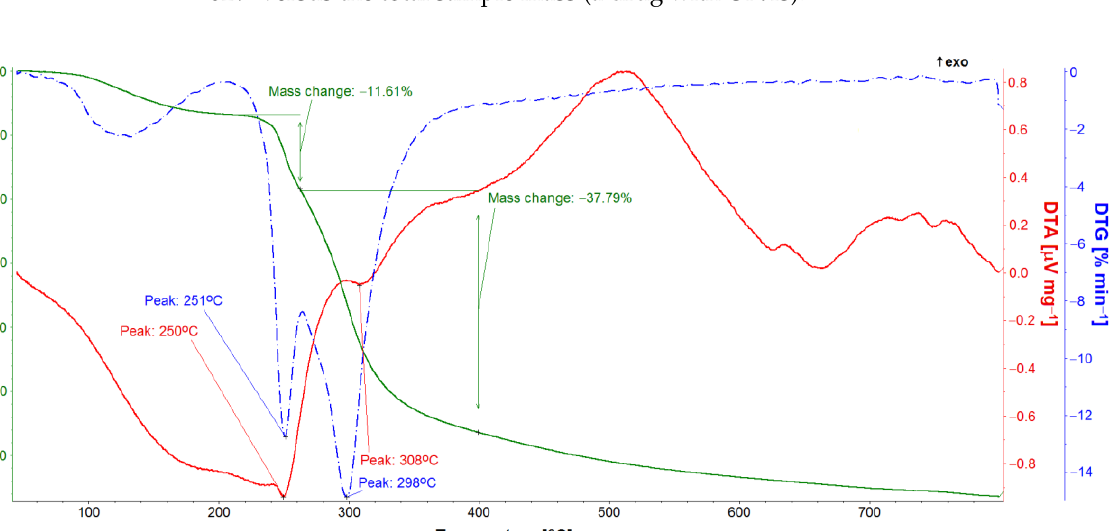
Figure 12. TG, DTA, and DTG curves and evolved gas analysis of gentamicin sulfate sample. Figure 13. TG, DTA, and DTG curves of gentamicin sulfate-loaded ONTs.